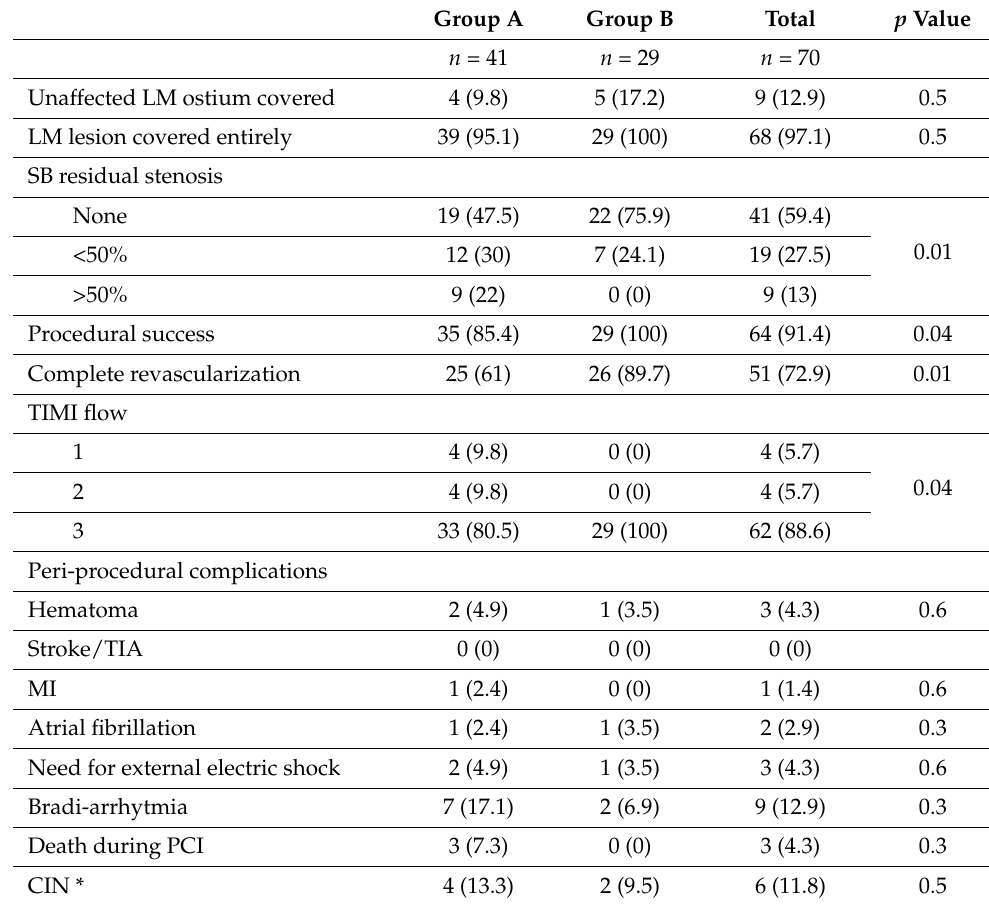
Table 4. Procedural outcomes and complications in patients with unprotected left main coronary artery disease and acute coronary syndrome (Group A—one stent strategy; Group B—two stent